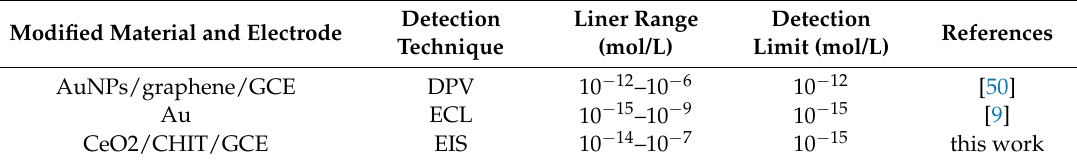
Table 2. Comparison of the CeO 2 /CHIT nanocomposite-based DNA biosensor with some previous works for detection Clostridium